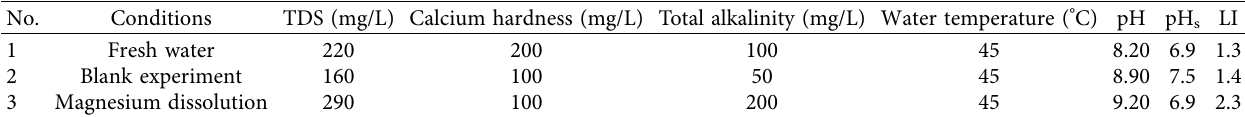
Figure 5: Time dependence of LPR corrosion rate in tap water depending on the test conditions: (a) the electrodes corrode in natural conditions; (b) the magnesium dissolution takes place in the setup (0.1A applied current); (c) the magnesium dissolution takes place in the setup (0.1 A applied current) and the probe’s electrodes are connected as cathodes (cathodic protection). Table 2: Water parameters in tap water depending on the test